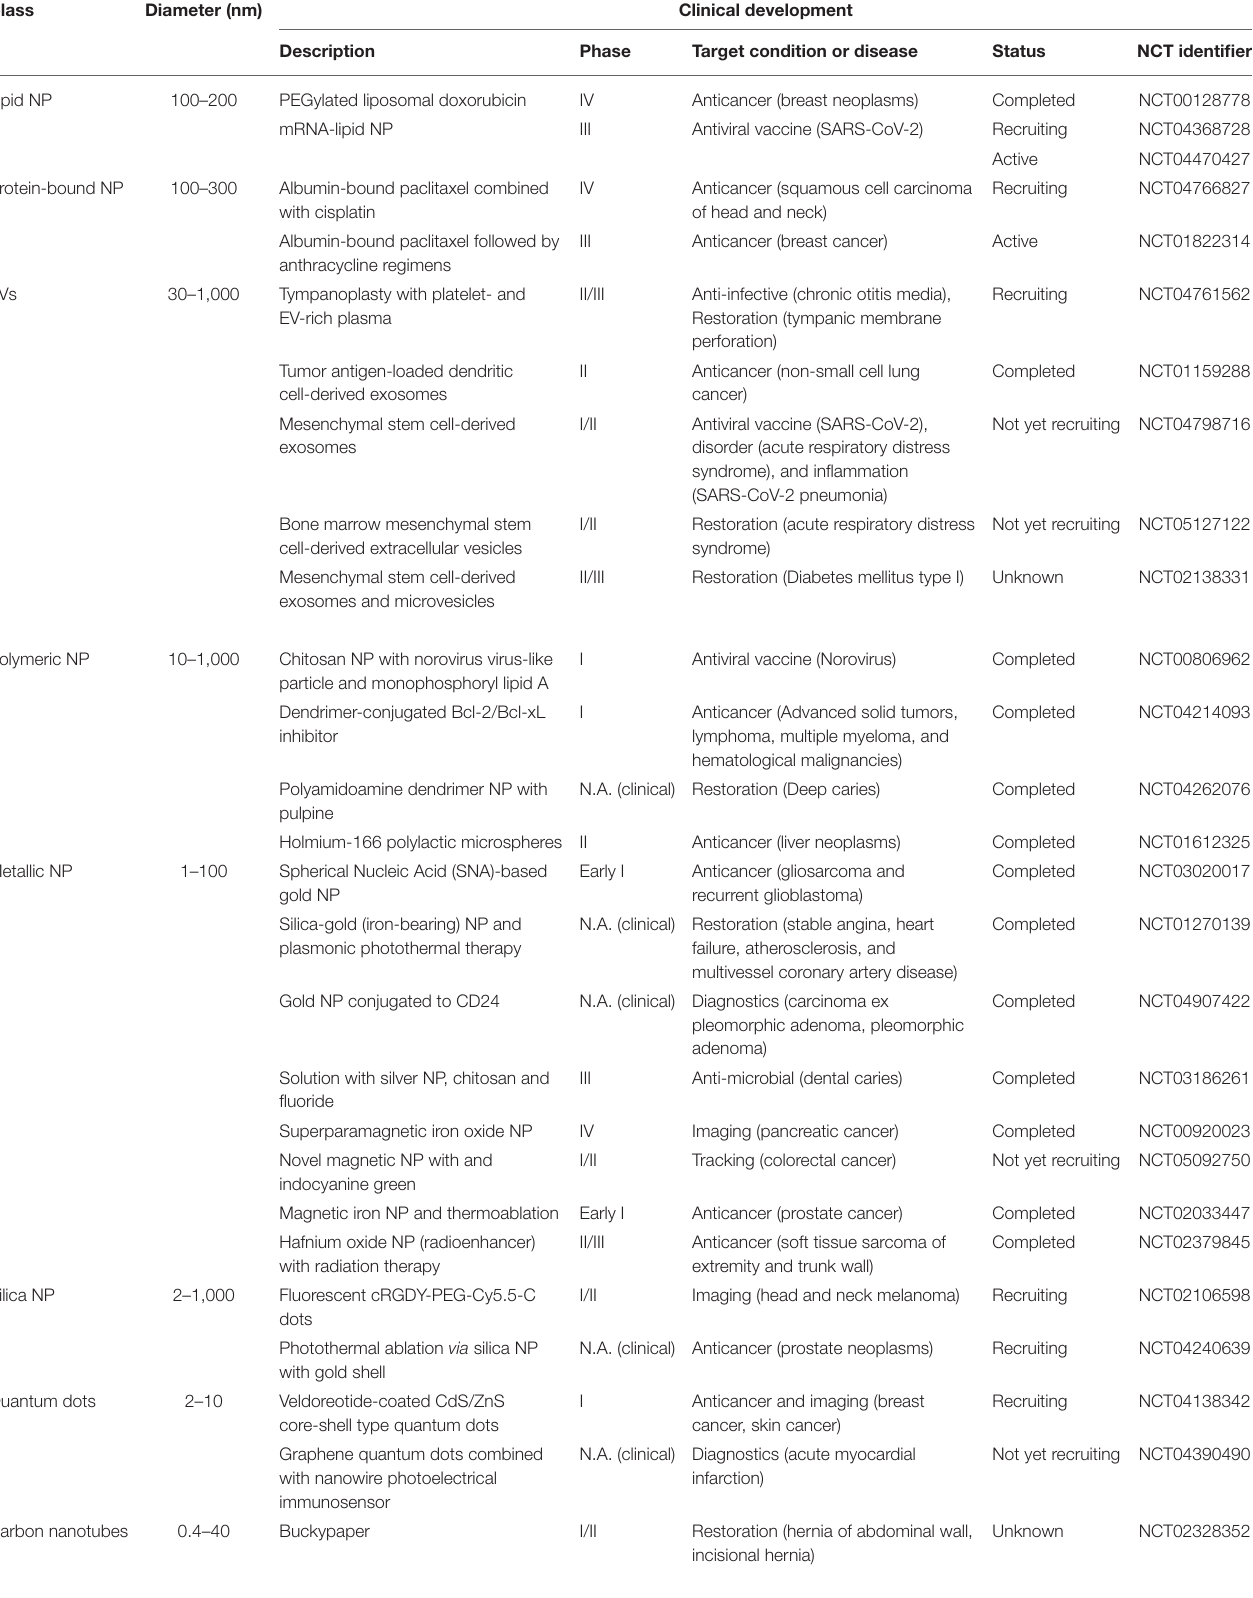
TABLE 1 | Various NP types used for clinical